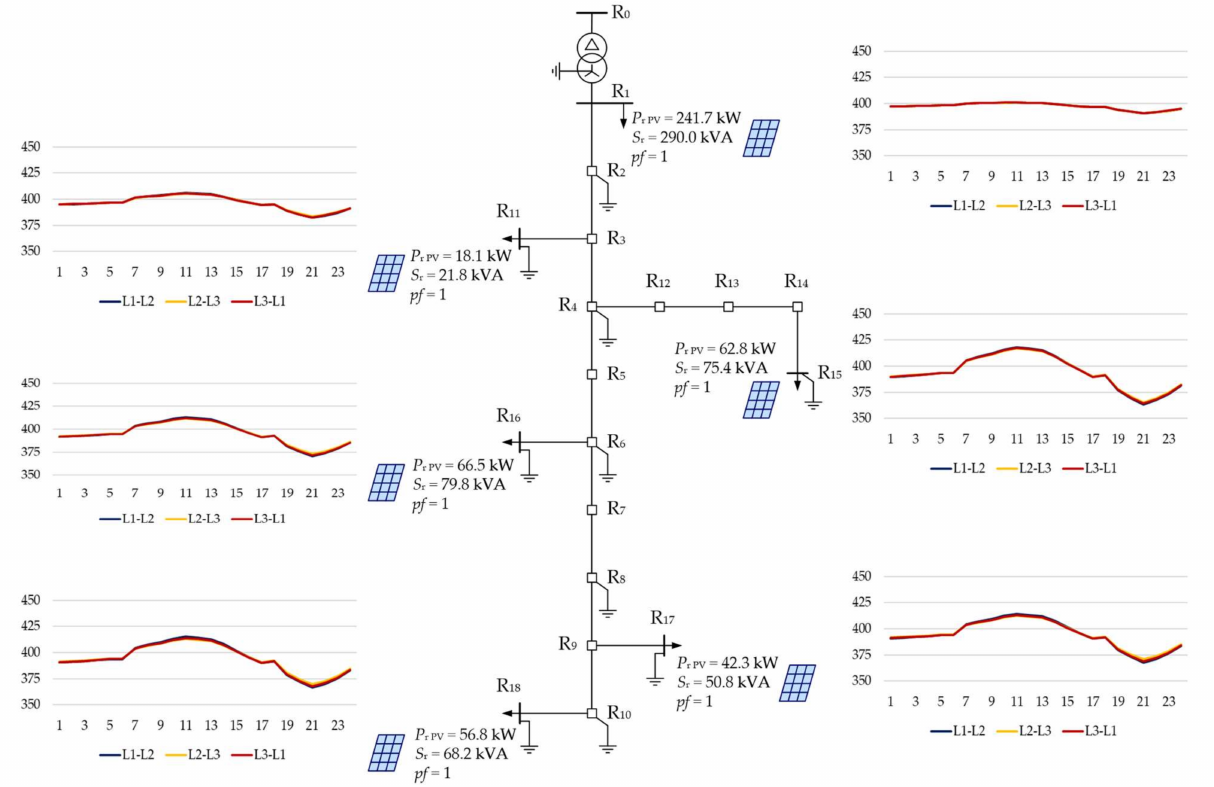
Figure 14. Daily simulation results showing the phase-to-phase voltages (V) in the test network for variant